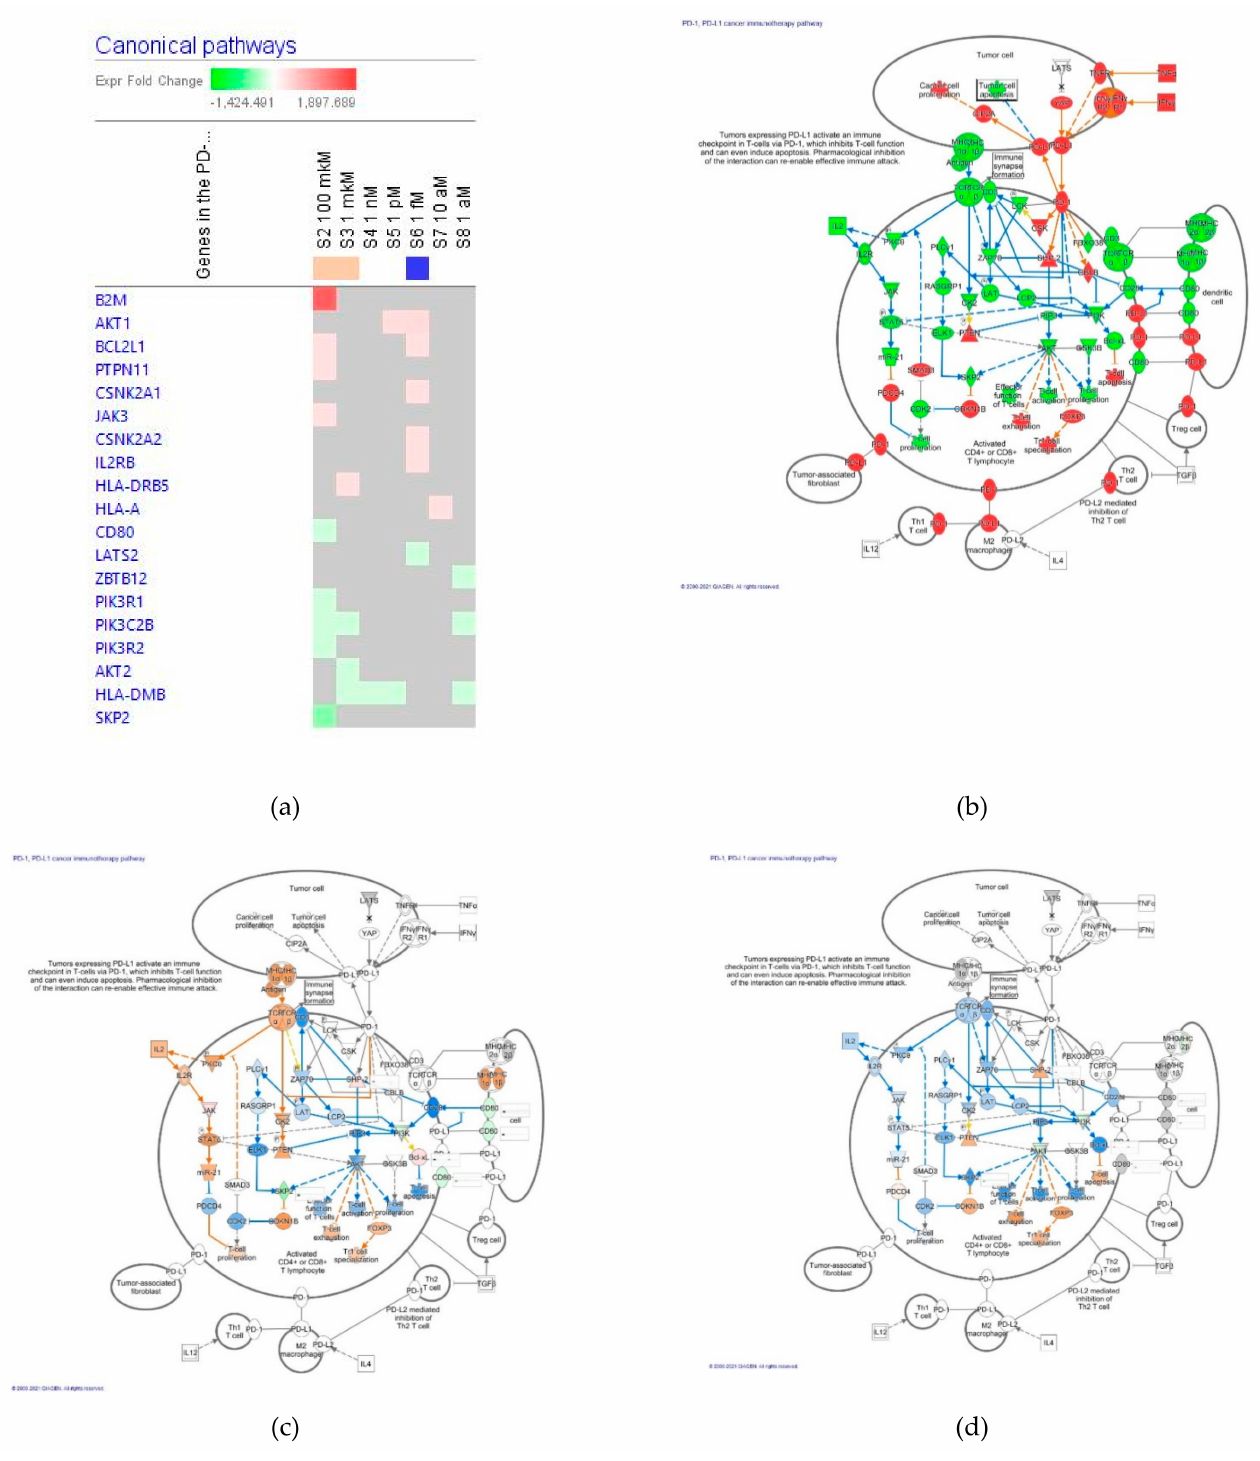
Figure 14. Effect of Rg5 on PD-1 cancer immunotherapy signaling pathway: ( a ) Heatmap of gene expression (in fold changes compared to control, red, upregulation and green, downregulation), after exposure with ginsenoside Rg5 at different concentrations; the 100 µ M signature is shown in the leftmost column as solid red or green squares indicating genes that are upregulated or downregulated, respectively; color intensity indicates the actual log-fold changes; ( b ) canonical pathway activation state; ( c ) Rg5 at a concentration of 100 µ M—predicted inhibition (blue) and activation (brown); ( d ) Rg5 at a concentration of 1 µ M—predicted inhibition (blue) and activation